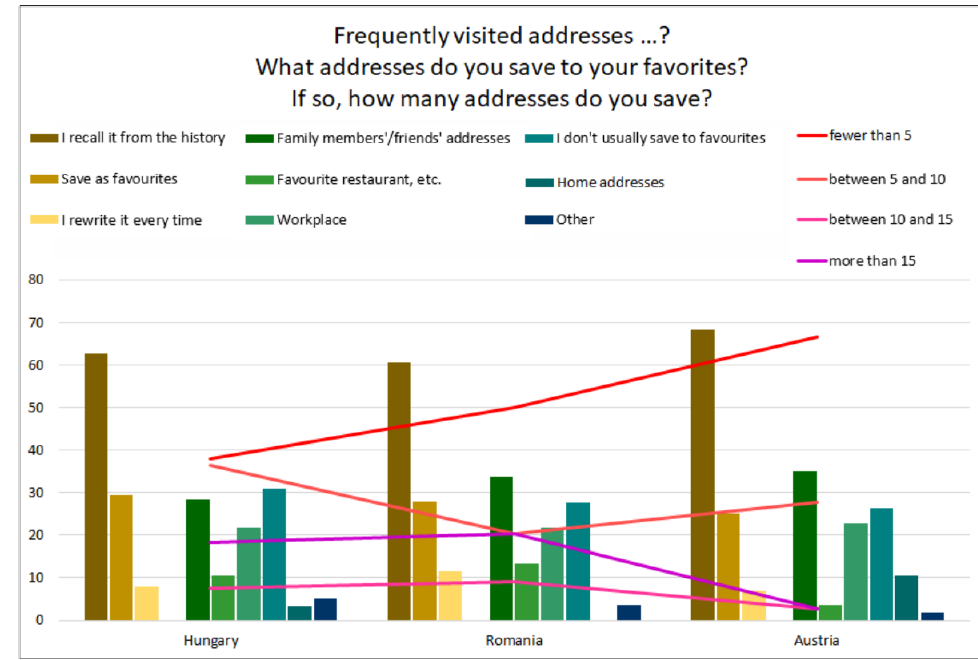
Figure 8. Answers about frequently visited addresses.